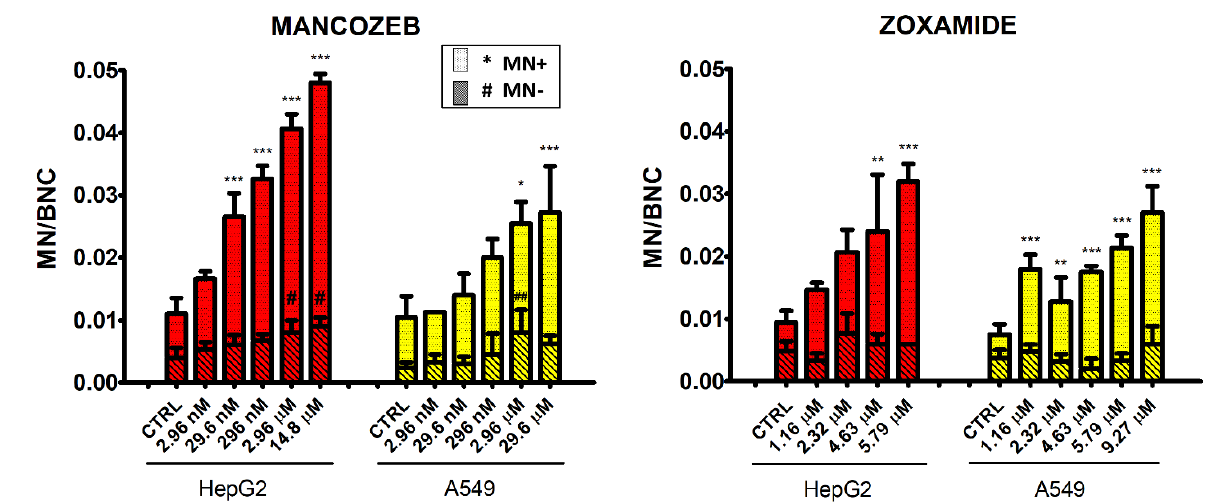
Figure 7. Frequencies of MNi counted in 500 binucleated HepG2 (red) and A549 (yellow) cells after 24 h of treatment with MZ, ZOX or medium alone as control. Bars with striped pattern represent the number of CREST-negative micronuclei (MN − ), filled bars represent the number of CREST-positive micronuclei (MN+). Values are means ± SEM of three independent experiments. Statistical significance is indicated by asterisks for MN+ comparisons and by hashtags for MN- comparisons: *, # statistically significant ( p < 0.05); **, ## ( p < 0.01); *** ( p < 0.001).